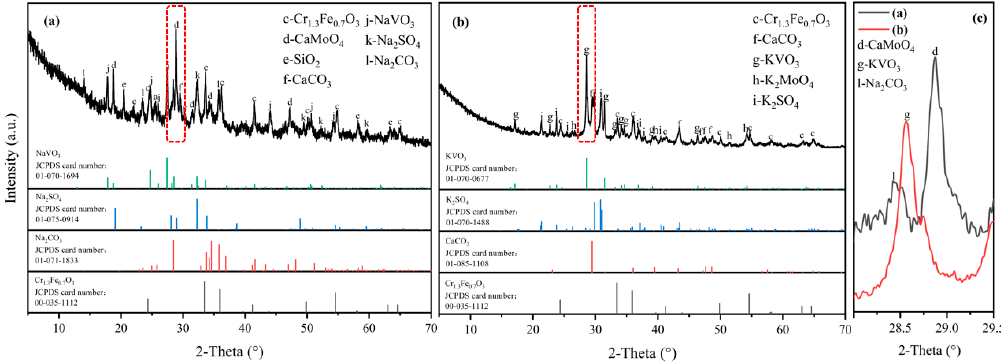
Figure 5. Characterization of the XRD patterns of CHCVR at 200 °C: the Na 2 CO 3 system ( a ), K 2 CO 3 system ( b ), and their magnified comparison diagram ( c ).